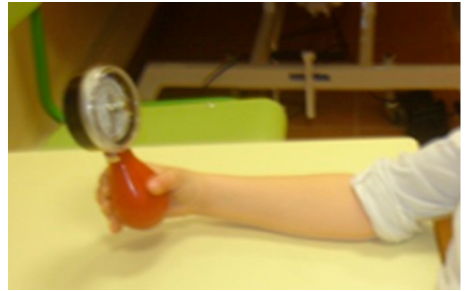
Figure 4. Grasp strength measurement with a hand dynamometer.